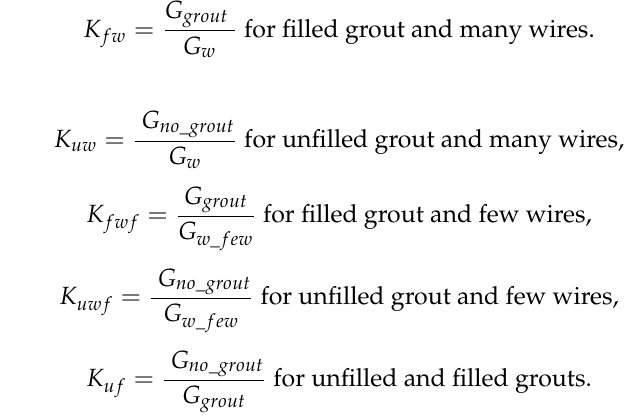
Figure 16. Gray value profile and the polynomial fitting along the line segment in Figure 14 as the background X-ray intensity distribution.